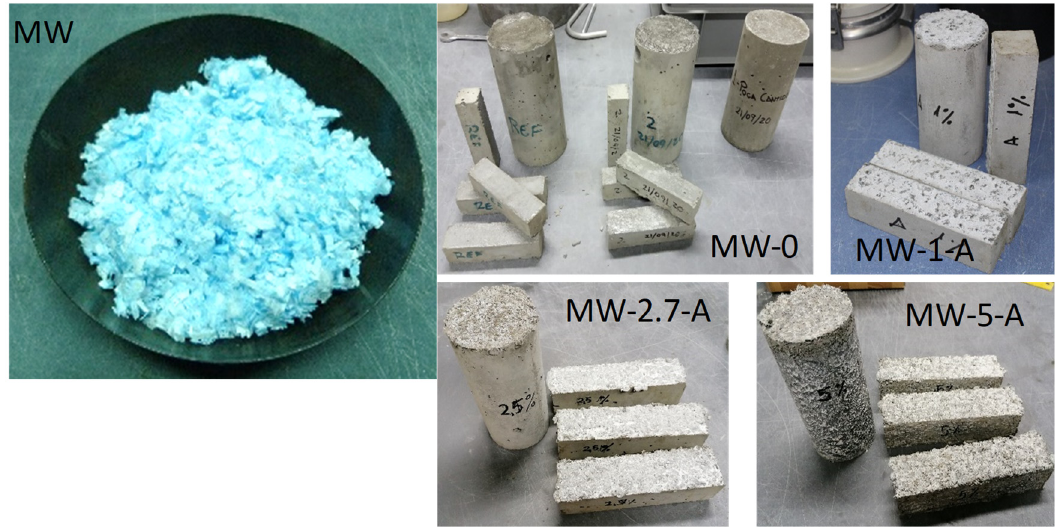
Figure 1. Shredded MW ready to be included in the mortar, and aspect of some of the